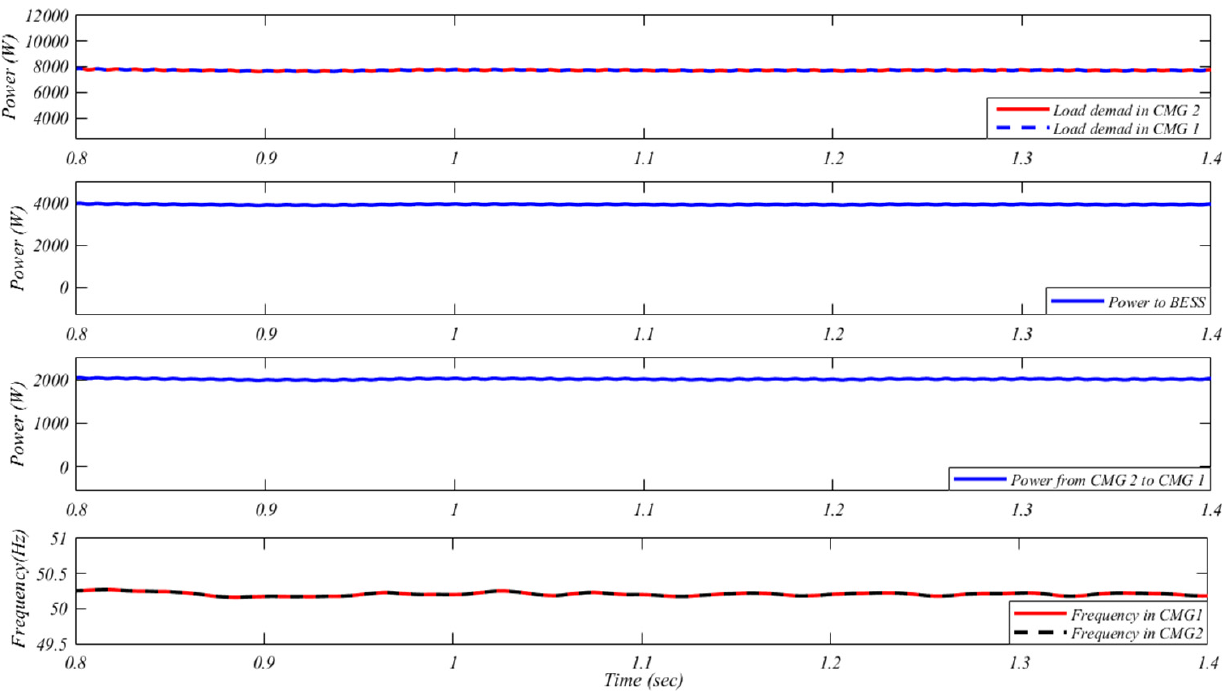
Figure 10. Illustration of BESS charging situation.